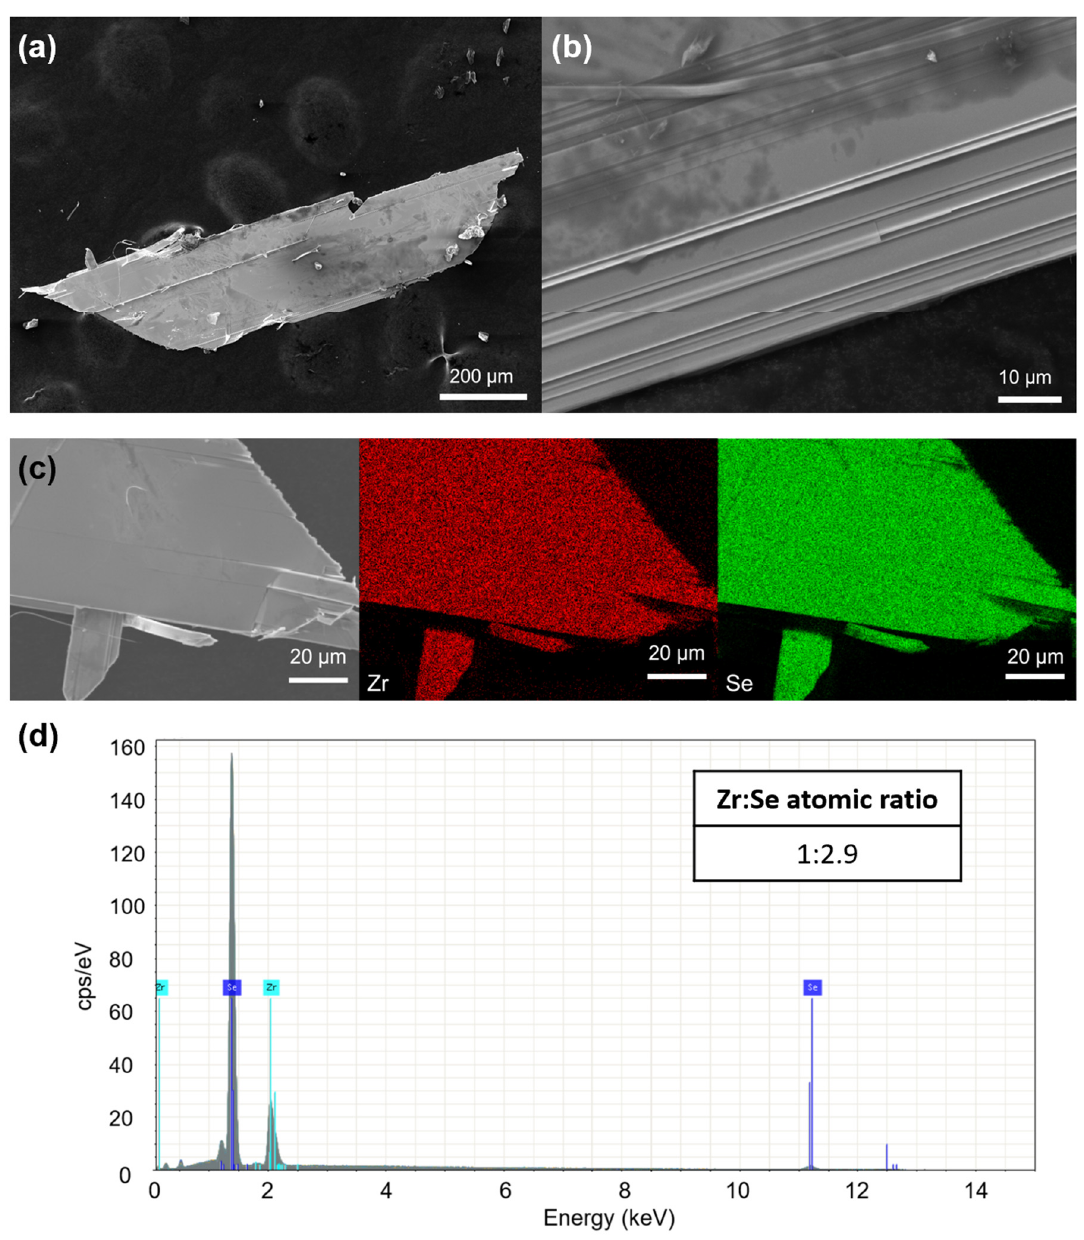
Figure 2. ( a , b ) SEM images of ZrSe 3 after CVT. ( c ) EDS elemental mapping of Zr and Se in a ZrSe 3 flake. ( d ) EDS spectrum of ZrSe 3 .